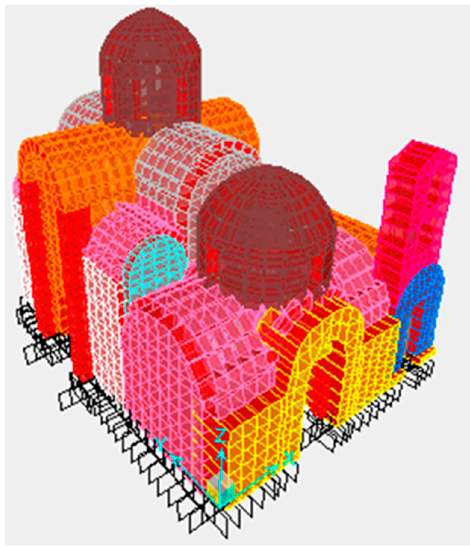
Figure 9. Finite element modeling of the Kaisariani monastery.